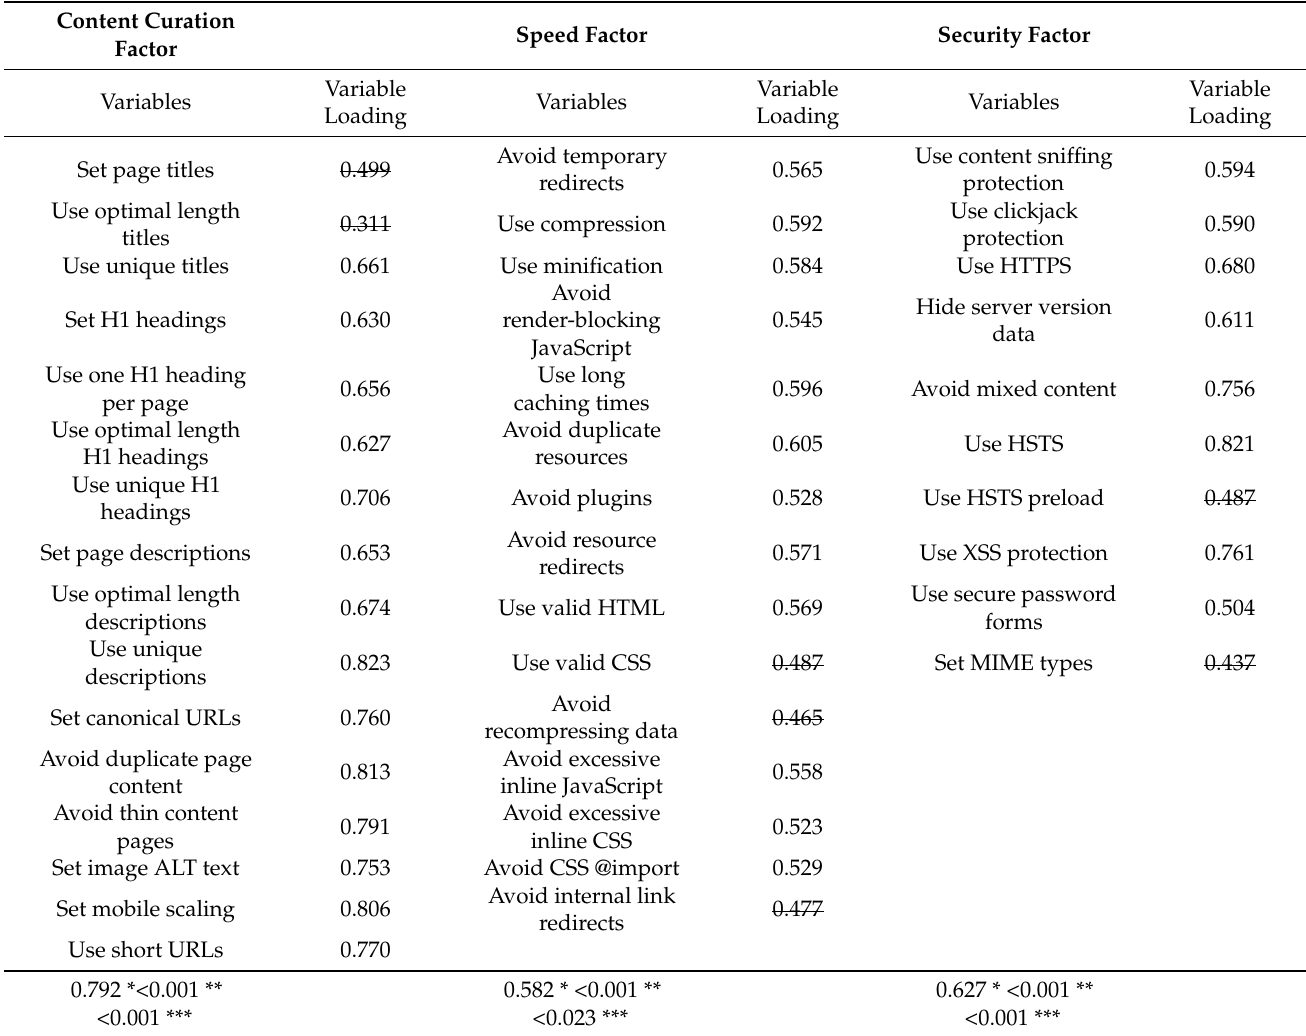
Table 2. Exploratory factorial analysis results and loadings per